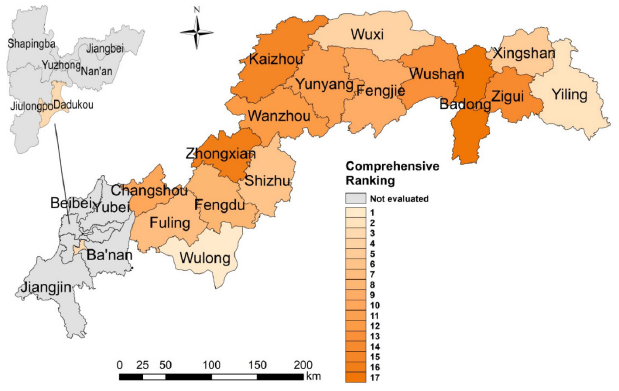
Fig. 6 . Disaster resilience ranking in the Three Gorges Reservoir Area.